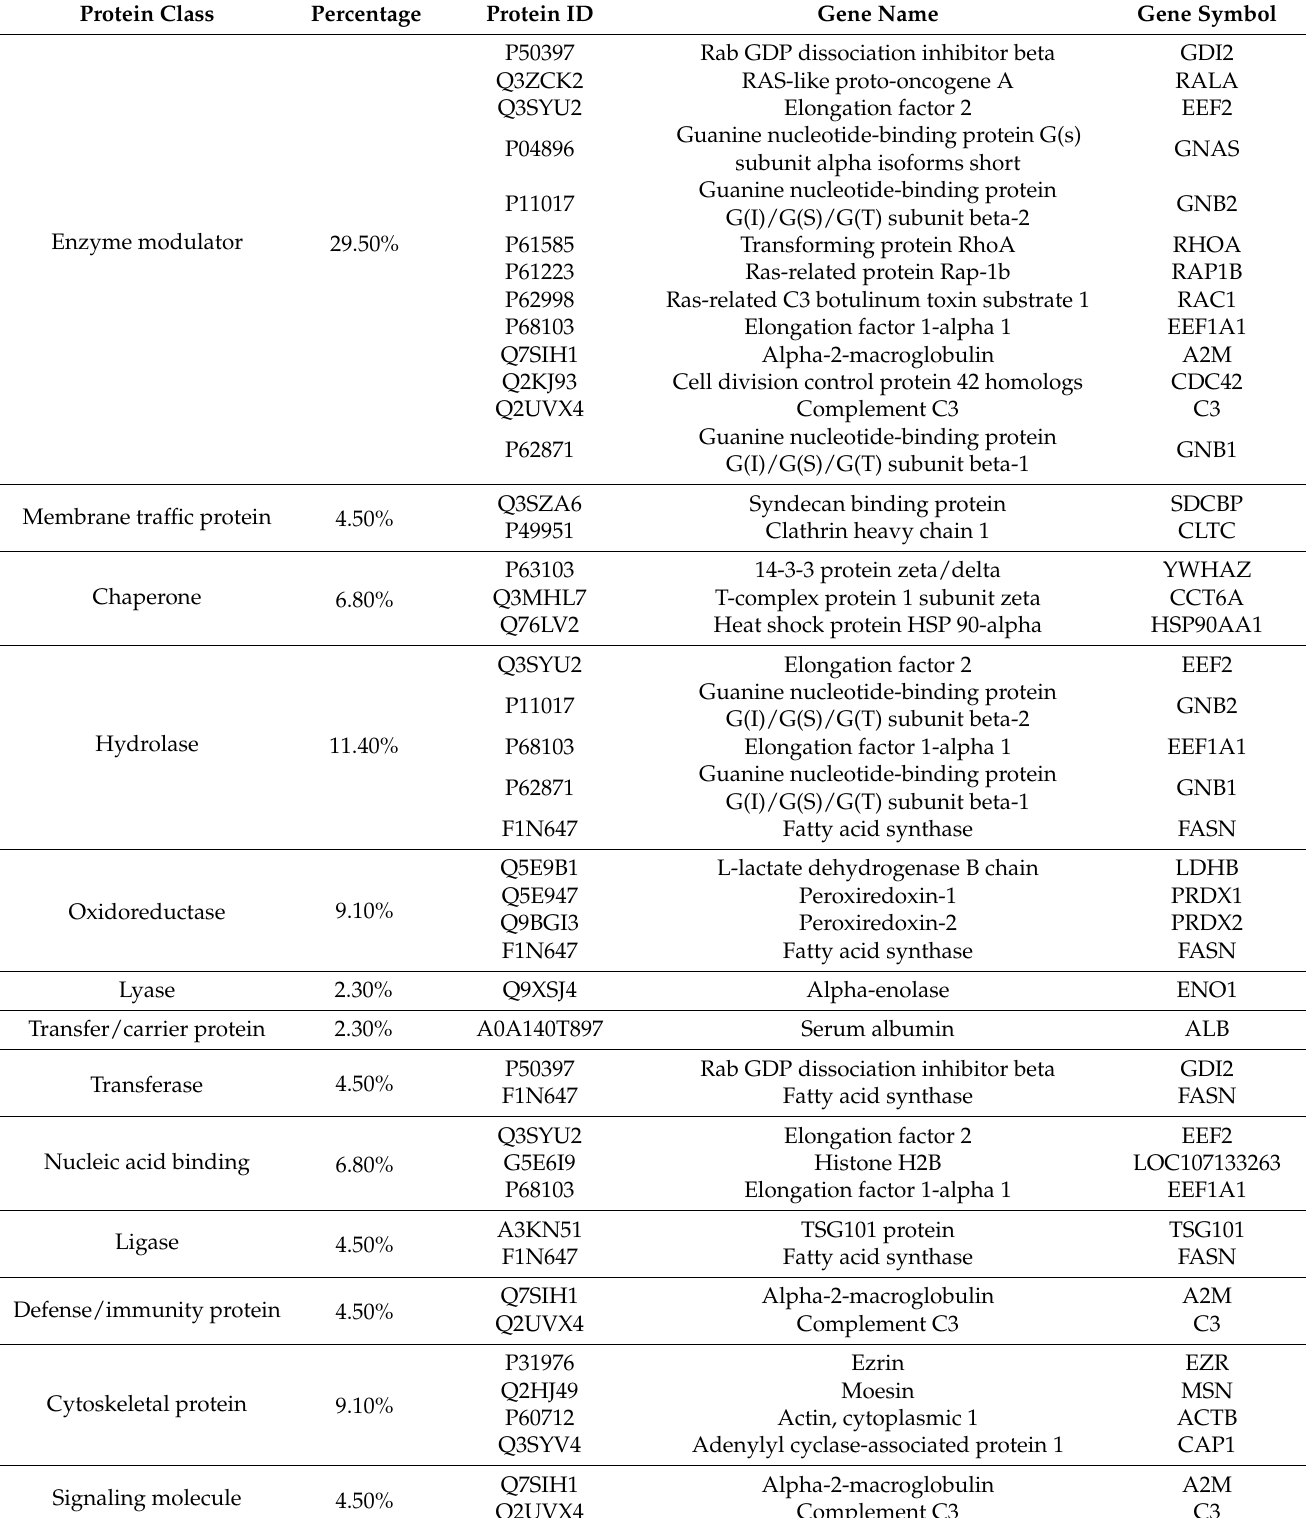
Table 3. Classes of milk extracellular vesicle-proteins included in the top 100